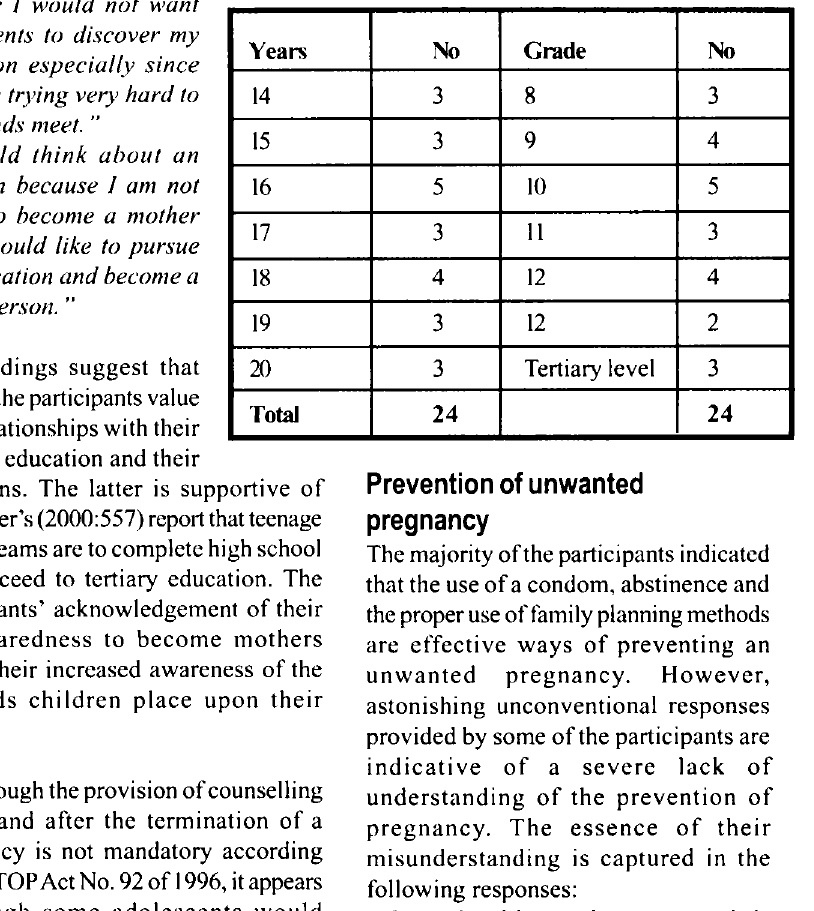
Table 1: Age and grades of